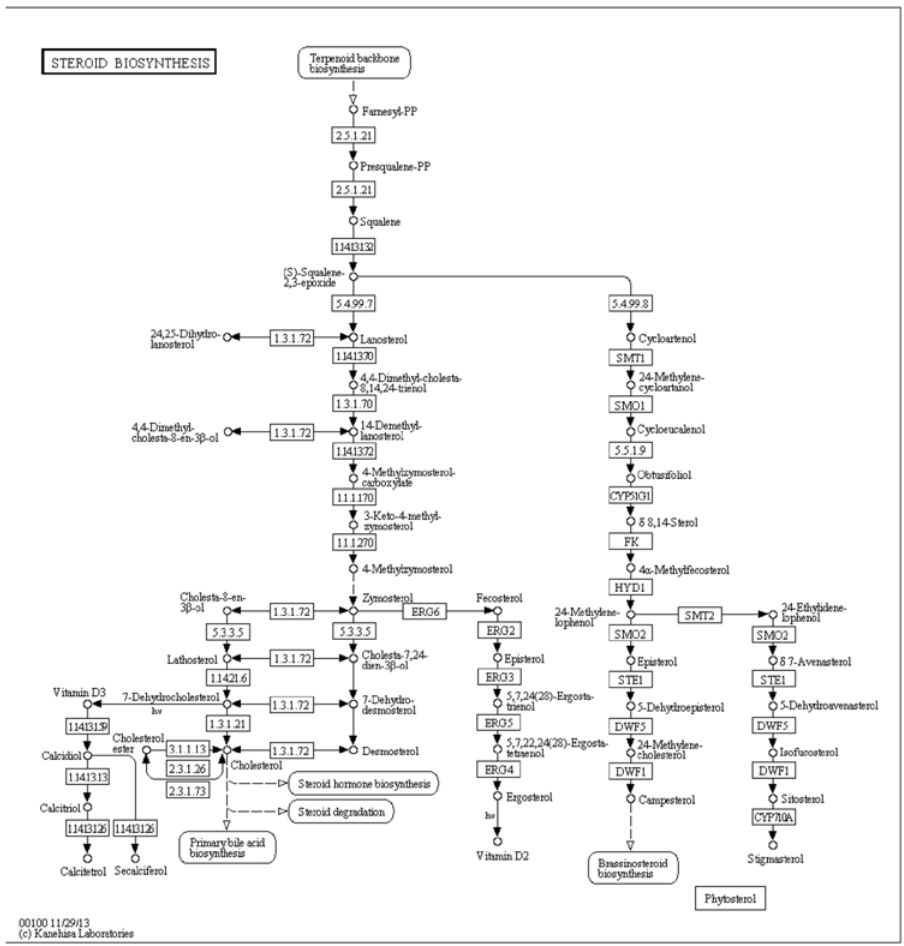
desulphuration, dehalogenation, and noxide reduction. In present research, Cytochrome P450 was up- regulated upon berberine chloride treatment, which suggested that it might be involved in tolerance of toxic